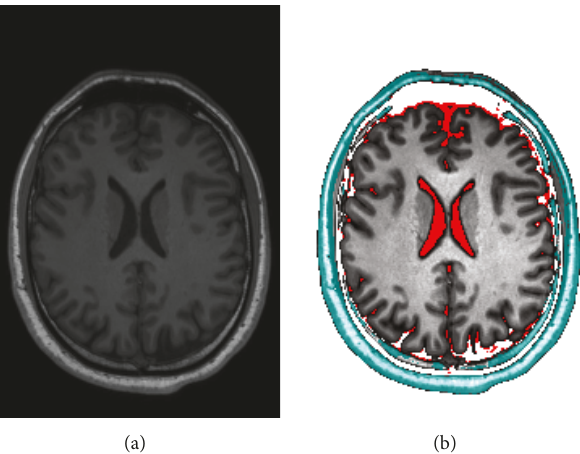
Figure 4: Slice of a brain MRI scan. (a) is normalized but otherwise unprocessed. (b) is segmented into skull/skin (teal), cerebrospinal fluid (red), and brain (grey) tissue. The brain tissue is contrast-enhanced.